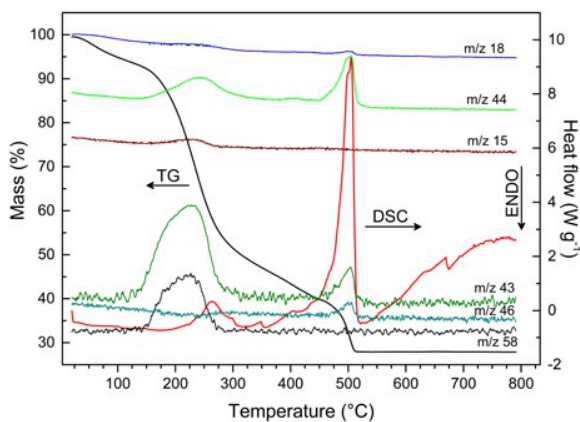
Figure 1. TG, DSC curves and signals from MS of undoped xerogel.